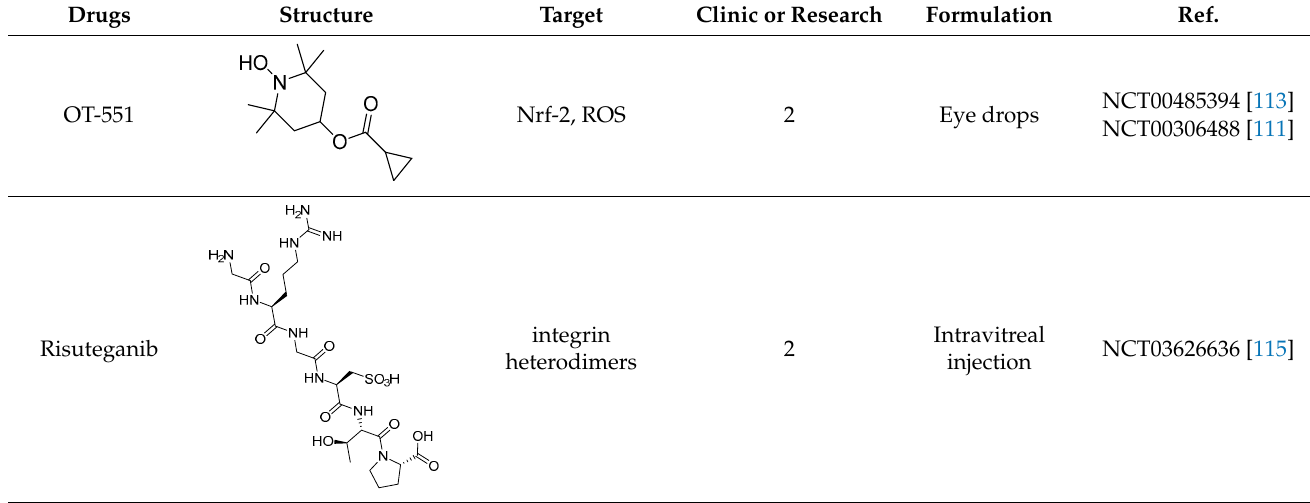
Table 4. Drugs targeting oxidative stress.